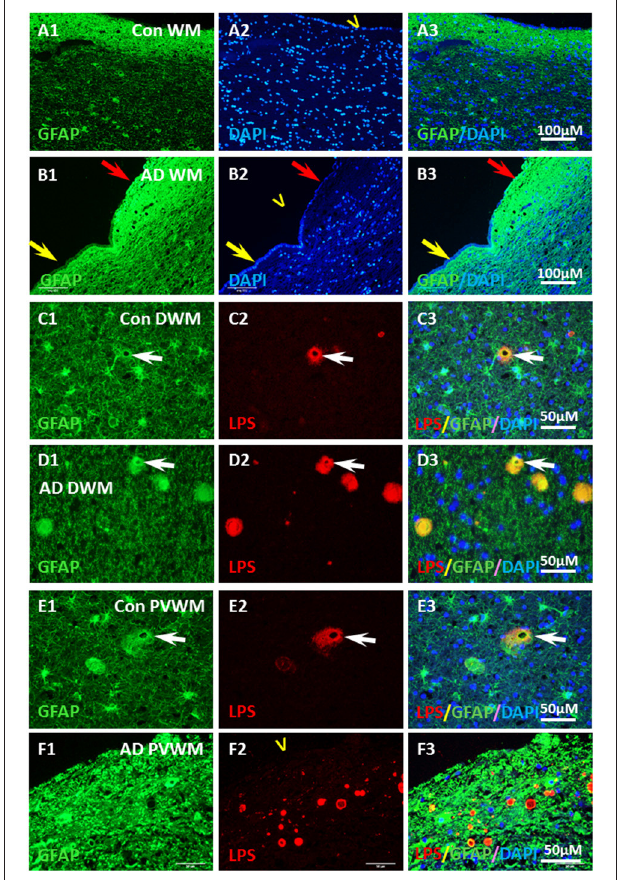
FIGURE 7 | Double immunostaining of LPS and microglial Iba1 in the PVWM of AD and aging control brains. (A) LPS (A2) and Iba1 (A3) in control PVWM did not co-localize (A1) . Iba1 stained microglia were sparse (A1,A3) . (B) LPS (B2) and Iba1 (B3) in AD PVWM did not co-localize (B1) . Iba1 stained microglia were sparse in AD PVWM (B1,B3) . Note: MDZ, myelin deficient zone; V, ventricle; LPS, lipopolysaccharide; Iba1, microglial marker; AD, Alzheimer’s Disease; Bar = 50 µ m.